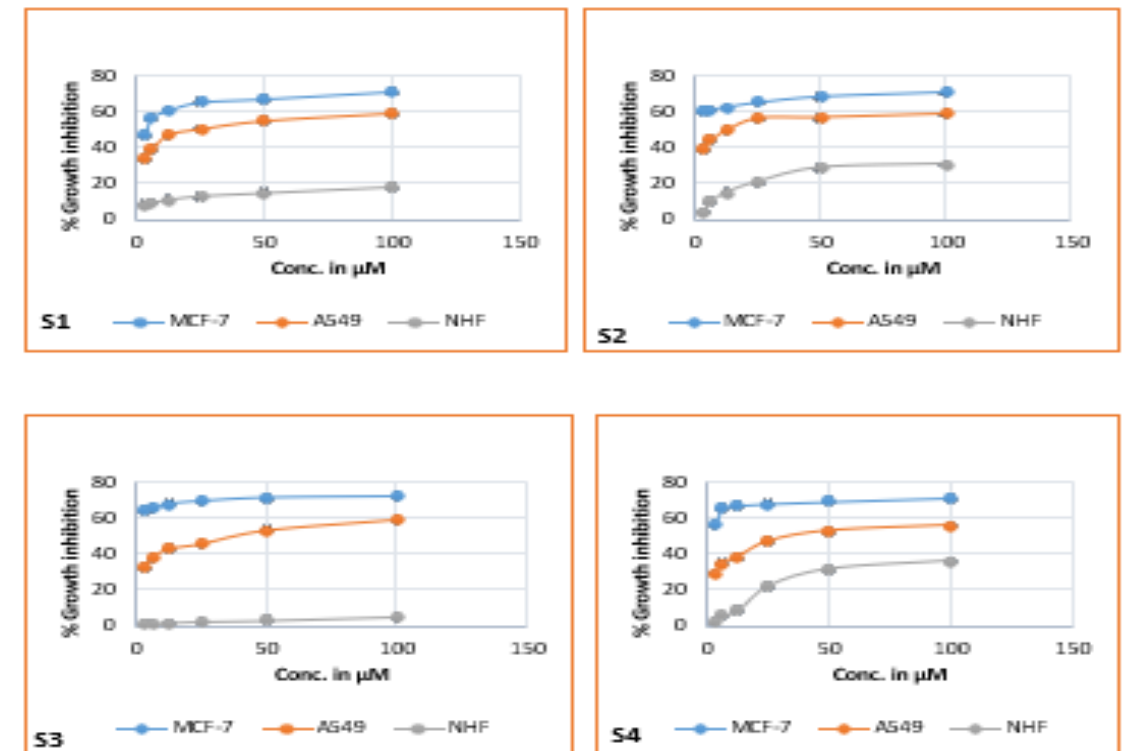
Figure 3. Concentration vs. growth inhibition curve of compounds (S1-S4) against breast cancer cells (MCF-7) (blue), lung cancer cells (A549) (orange) and healthy fibroblast cells (NHF) (gray). (Values are represented by the mean ± SEM of triplicate measurements).